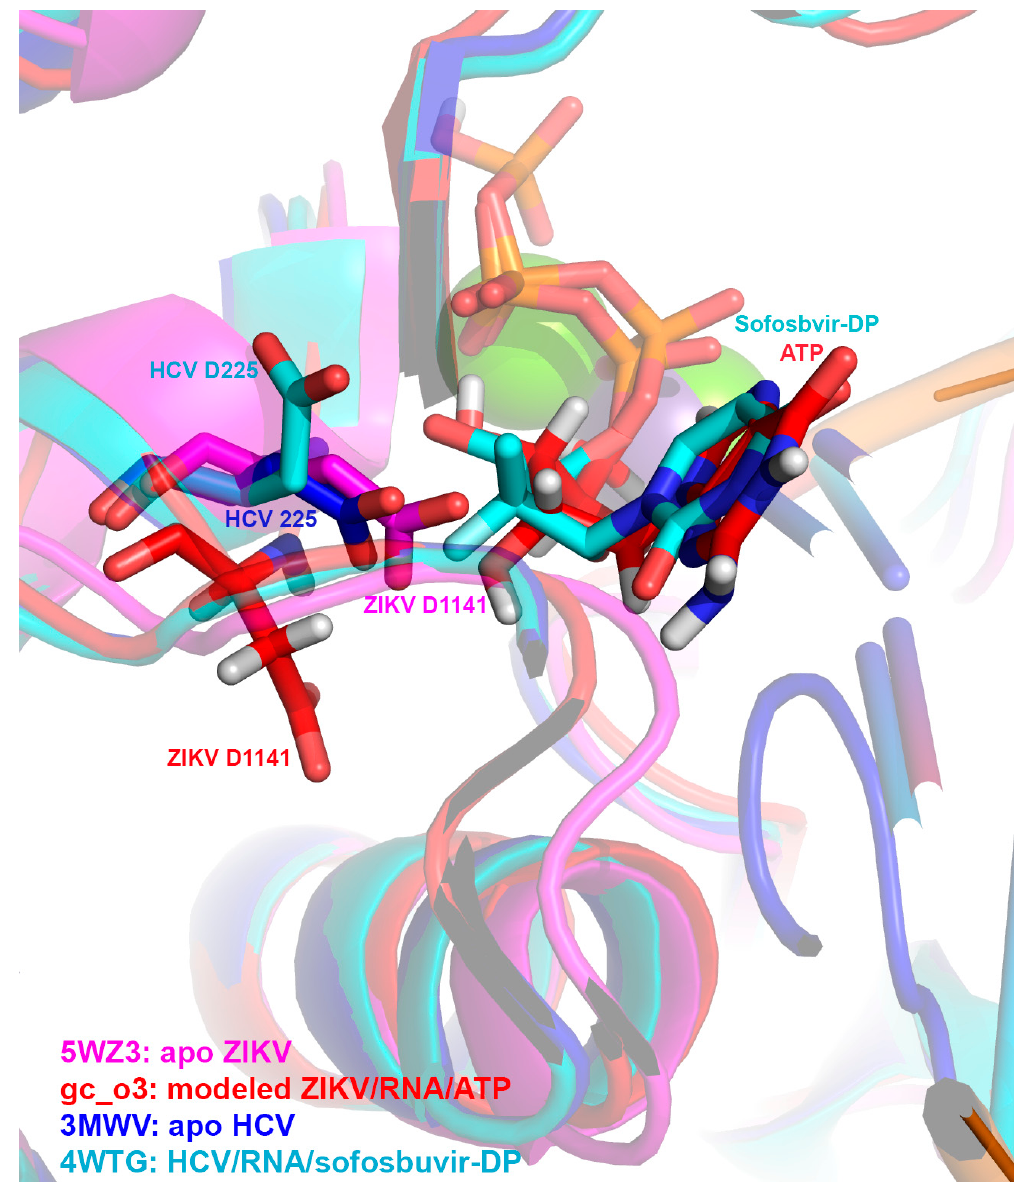
Figure 5. Structural superpositioning of apo and bound ZIKV RdRP and hepatitis C virus (HCV) RdRP. The ZIKV RdRP model gc-o3 [34] in complex with two manganese ions (green), ATP (red / CPK coloring), and RNA (orange / CPK coloring) is shown in red, and a crystal structure of apo ZIKV RdRP is shown in magenta (PDB 5WZ3 [38]). A crystal structure of HCV RdRP complexed with sofosbuvir diphosphate (cyan / CPK coloring), RNA (orange / CPK coloring), and a manganese ion (purple) is shown in cyan (PDB 4WTG [36]), and an apo structure of HCV RdRP is shown in blue (PDB 3MWV [39]). A comparison of the homologous residue D225 (HCV RdRP) and D1141 (ZIKV RdRP) is highlighted in stick form.